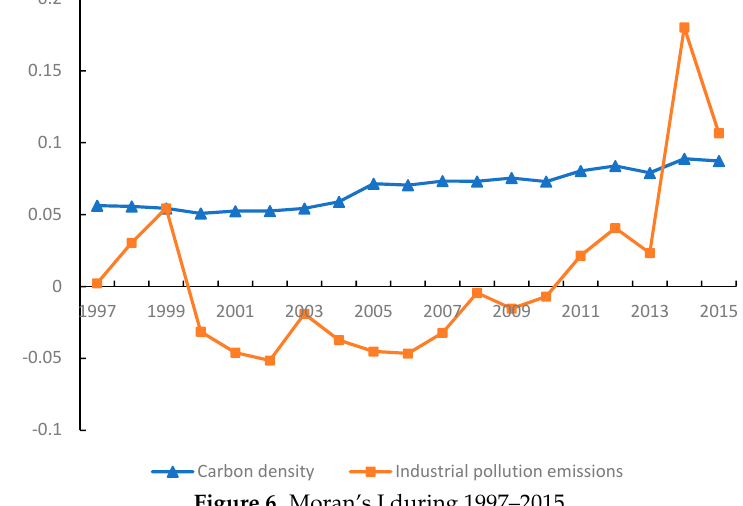
Figure 6. Moran’s I during 1997–2015.